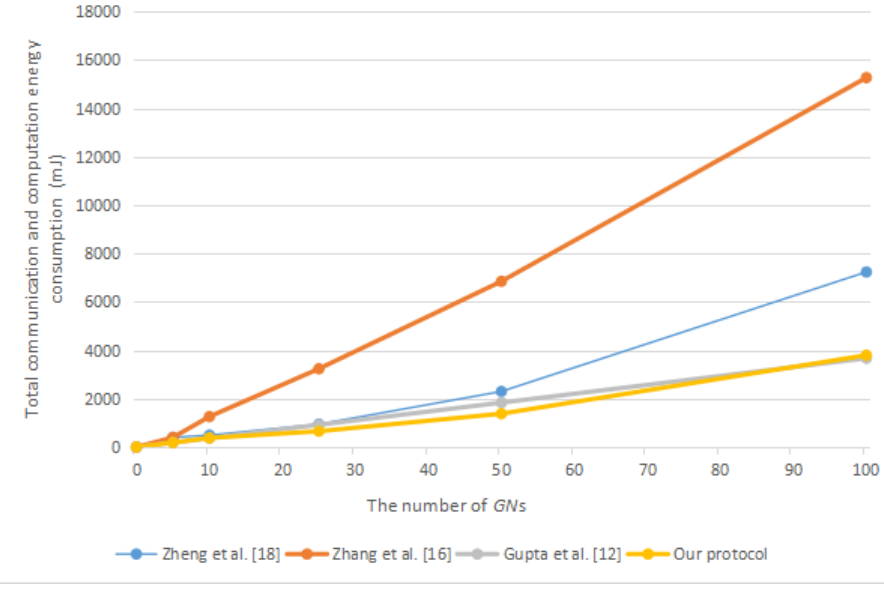
Figure 10. The total communication and computation energy consumption in different